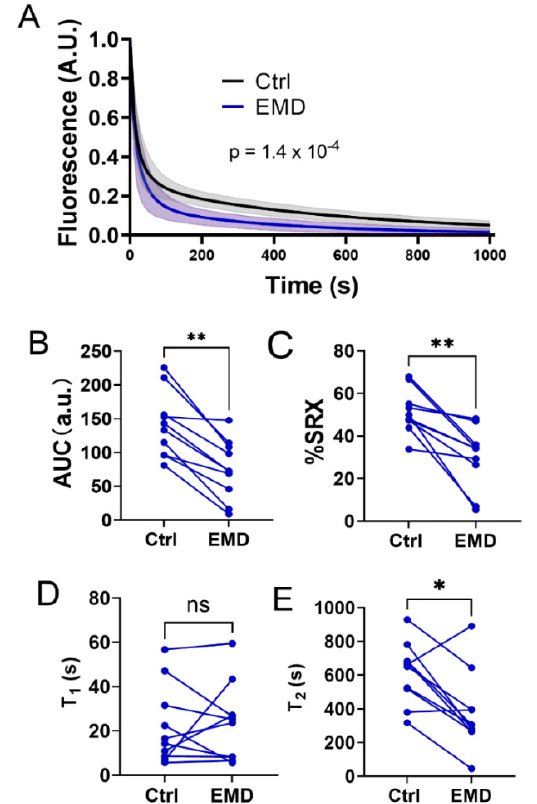
Figure 2. Mant-ATP assay from the permeabilized porcine myocardium before and after the EMD treatment. ( A ) Time course of the mant-ATP dissociation over time curves in the absence (black) and presence (blue) of 10 uM. ( B ) Area under the curve (AUC) of the mant-ATP dissociation time course (through 1000 s) before and after the EMD treatment. ( C ) The percentage of myosin heads in the SRX state (% SRX) before and after the EMD treatment. ( D ) The time constant of the fast phase (T1) before and after the EMD treatment. ( E ): The time constant of the slow phase (T2) before and after the EMD treatment. ns: not significant, * p < 0.05, ** p < 0.01.